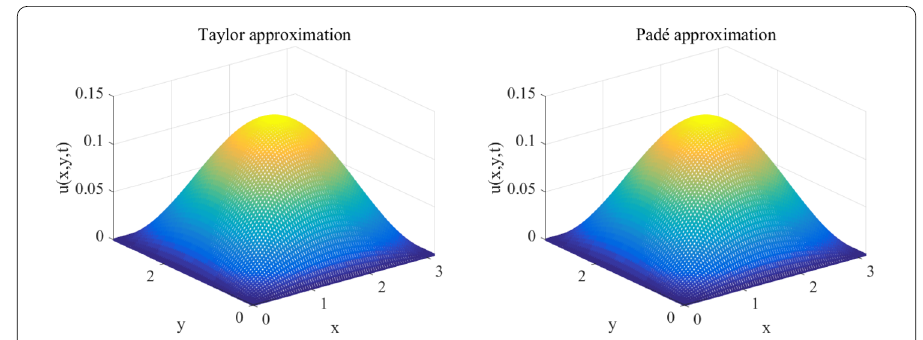
Figure 16 The numerical solutions of the CFDS-PIM of the Taylor approximation (on left-hand side figure) and the numerical solutions of the CFDS-PIM of the Taylor approximation and the Padé approximation (on right-hand side figure) for two-dimensional problem at t = 1 with N = 81 × 81 for Example 5